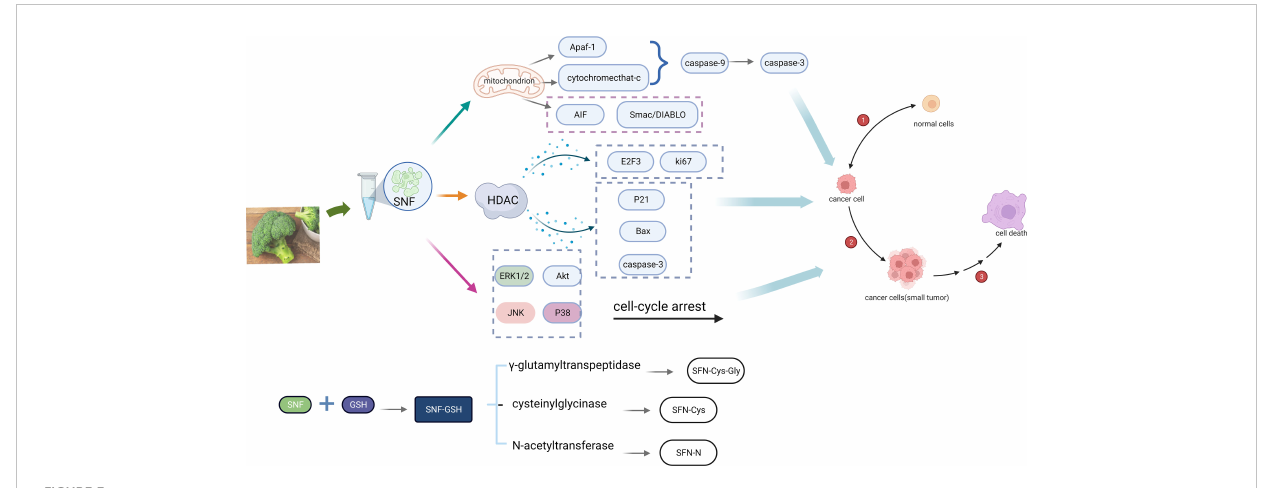
FIGURE 3 Mechanism of anti-cancer action of SFN (Created with